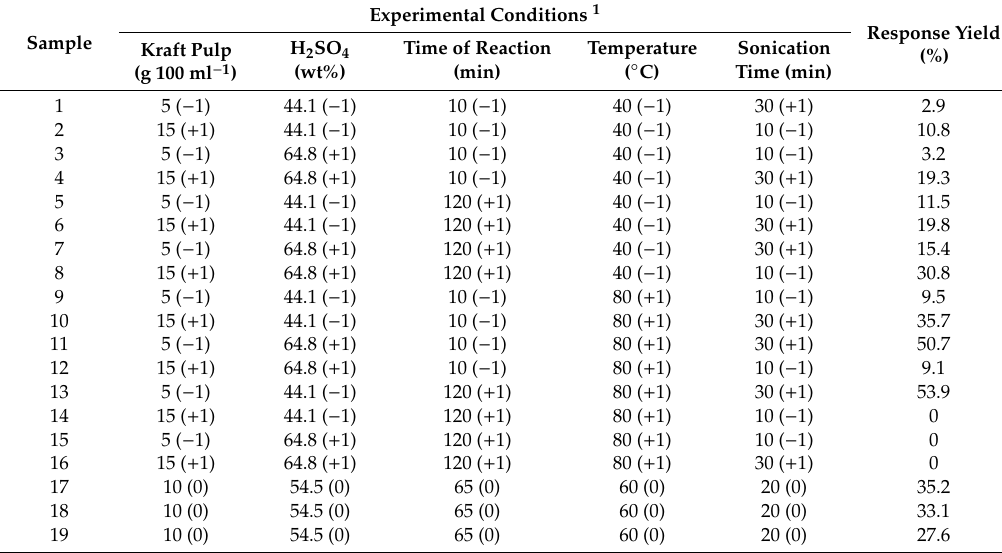
Table 2. Experimental conditions and the response of CNC